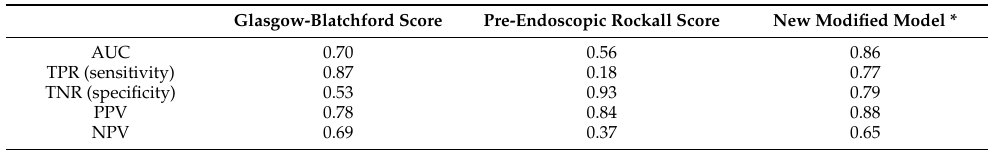
Table 3. Prediction model performance for endoscopic intervention and/or packed blood cells blood